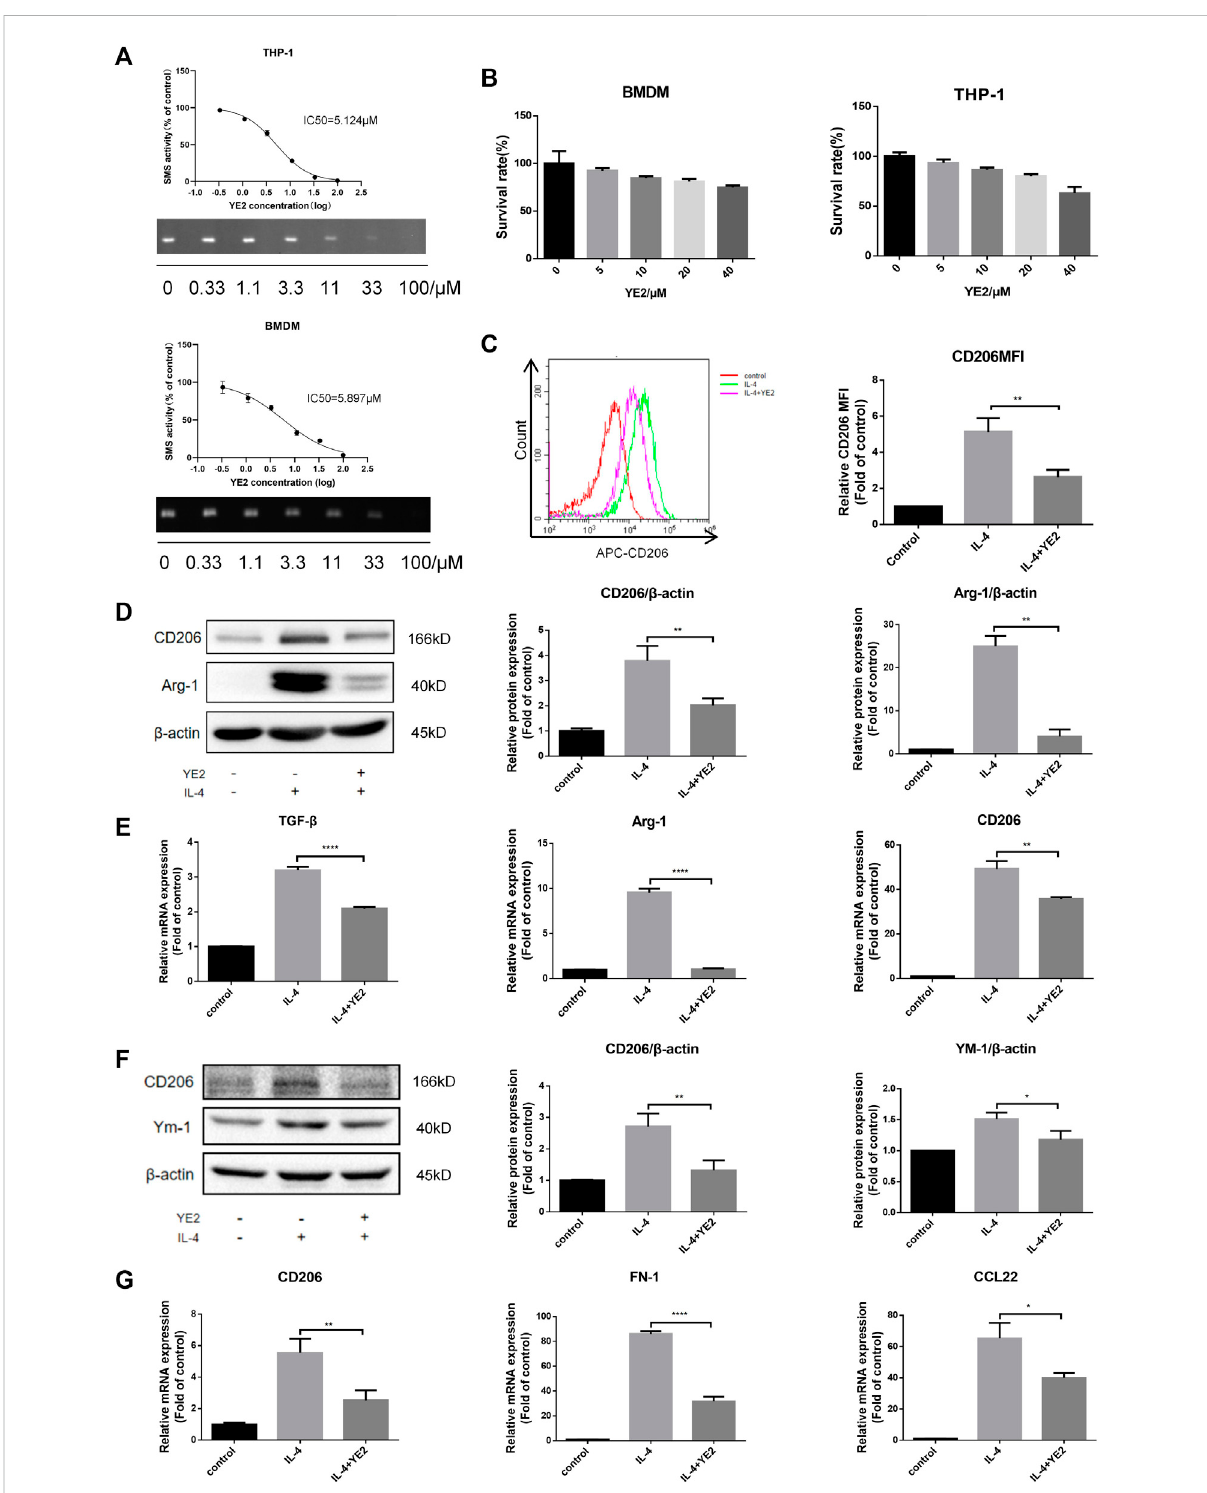
FIGURE 3 SMS2 selective inhibitor inhibits IL-4 induced M2 polarization in vitro . (A) . TLC measurements of SMS2 enzyme activity inhibition by YE2 in BMDM and THP-1. (B) . CCK8 measurements of the cell viability of BMDM and THP-1 with different concentration of YE2. (C) . Flow cytometric detectionofM2polarizationinducedbyIL-4for48 hinBMDMwithorwithoutYE2andquanti fi cationofCD206mean fl uorescenceintensity(MFI)in BMDM. Immunoblotting of BMDM (D) and THP-1 (F) 48 h after IL-4 stimulation. Real-time PCR was performed 24 h after IL-4-stimulated M2 polarization in BMDM (E) and THP-1 (G) . Data is presented as the mean ± SD of three representative experiments. * p < 0.05; ** p < 0.01; *** p <